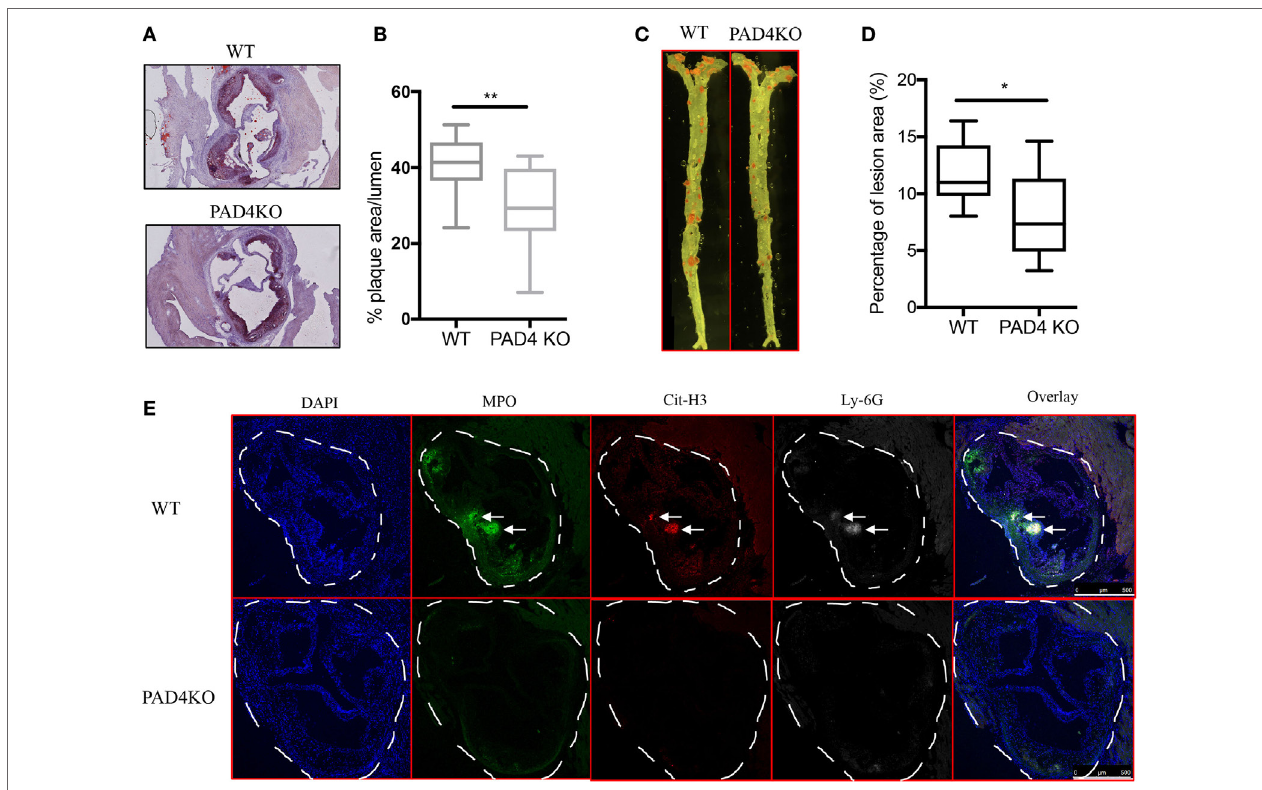
FigUre 3 | Lack of peptidylarginine deiminase 4 (PAD4) in myeloid lineage reduces atherosclerosis burden in association with diminished neutrophil extracellular trap (NET) formation in the artery. WT and PAD4 KO mice were fed high-fat chow (HFC) for 10 weeks. (a) Representative images of aortic root sections from WT and PAD4 KO mice stained with Oil Red O (red) and hematoxylin. n = 13–14/group in two independent experiments. (B) Quantitation of plaque area relative to the aortic lumen area of aortic root sections from WT and PAD4 KO mice placed on HFC for 10 weeks. (c) Representative images of en face preparations of intact aortas from WT and PAD4 KO mice placed on HFC for 10 weeks and stained with Sudan IV (Red) ( n = 8–9/group in two independent experiments). (D) Quantitation of plaque area from the en face preparations of intact aortas from WT and PAD4 KO placed on HFC for 10 weeks. (e) Representative confocal immunofluorescence microscopy images of aortic root sections from WT and PAD4 KO mice placed on HFC for 10 weeks and stained for DNA (DAPI, blue), MPO (green), Cit-H3 (red), and Ly-6G (white). Areas of netting neutrophils are observed in the WT but not in the PAD4 KO mice. White arrows indicate NETs area. Data are representative of six mice in each group in two independent experiments. * p < 0.05, ** p <